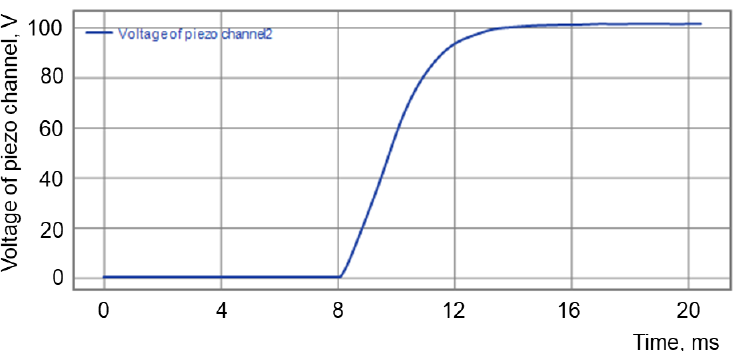
Figure 8. Time characteristics of the piezo element P-602 [36] used for the fast opening